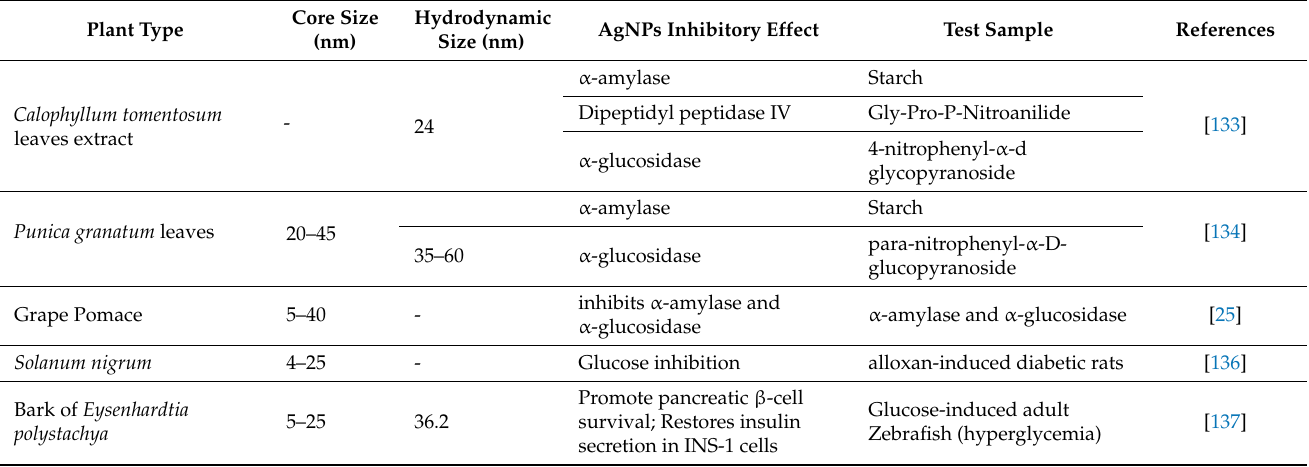
Table 6. Plant-synthesized AgNPs with anti-diabetic